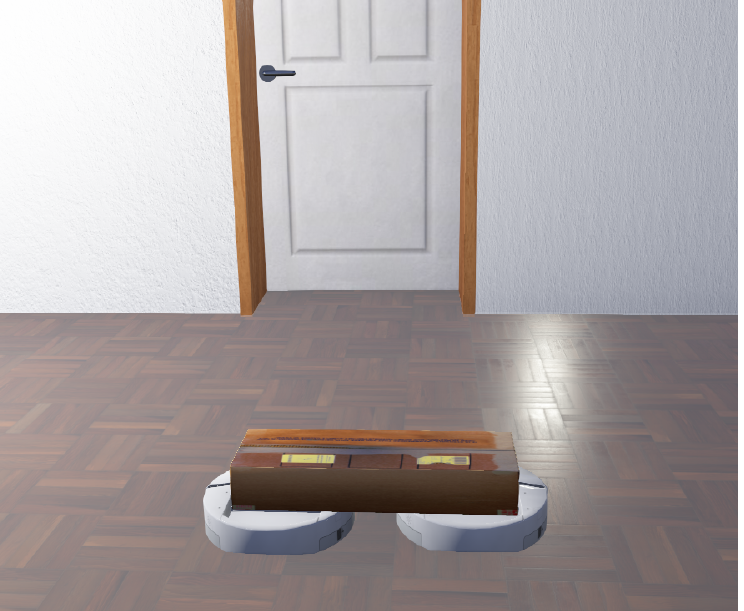
Figure 13. An illustration of multi-robot object transportation is presented where 2 iRobot Create robots carry a cardboard box and plan to go through a door in front of